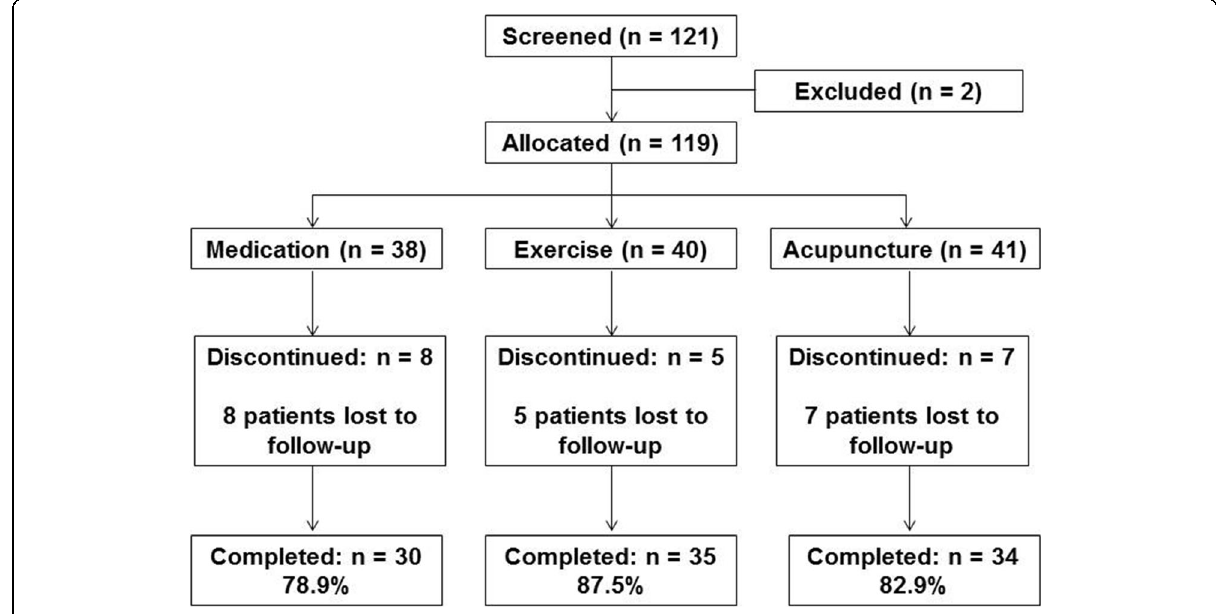
Fig. 2 Flowchart of participants in LAP